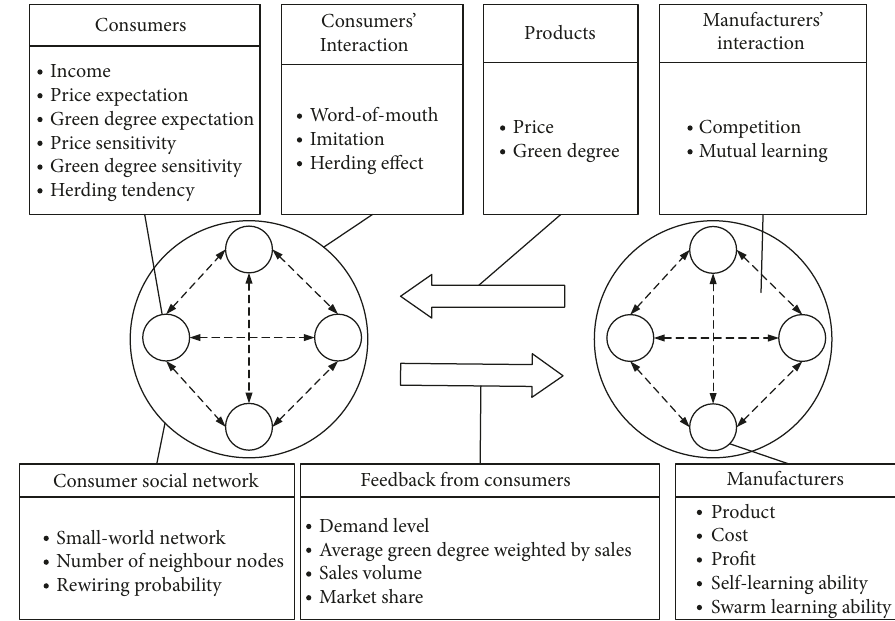
Figure 1: The system structure